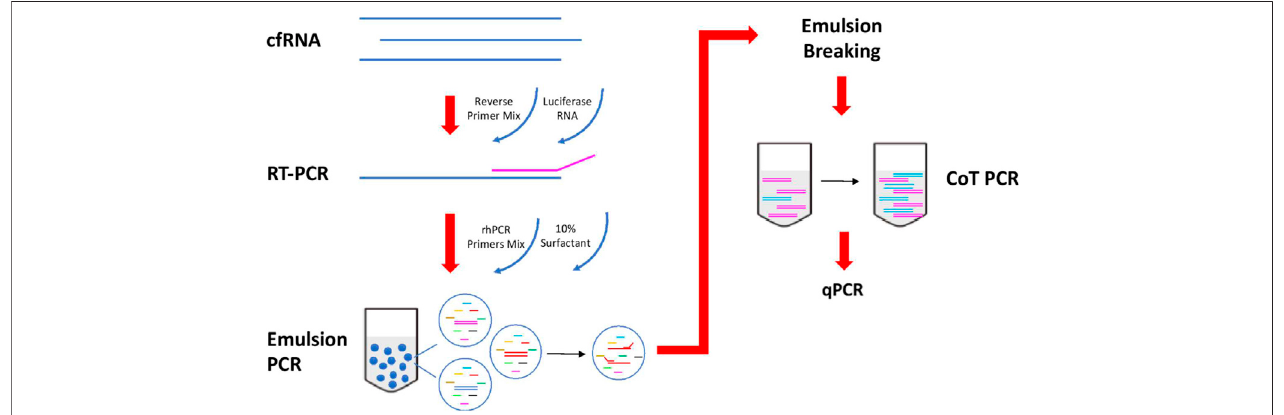
FIGURE 1 | Work fl ow of reverse transcription and ampli fi cation of cfmRNA. cfmRNA, spiked-in with luciferase RNA control, was reverse transcript with Superscript ™ IIIReverseTranscriptase(Invitrogen,Catno.18080044).Theproductwasampli fi edwithrhPCRprimersandPlatinum ™ TaqDNAPolymerase(Invitrogen, Cat no. 10966) using emulsion and CoT PCR. The residual primers were removed with Exonuclease I (New England Biolabs, Cat no. M0293). Ampli fi ed products were used for qPCR quanti fi cation and